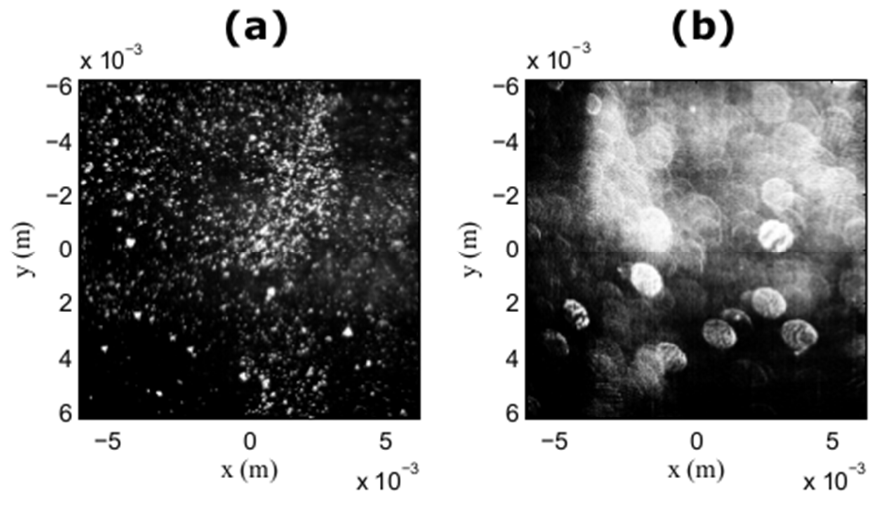
Figure 9. In-focus image of the measurement field when packets of nitrogen particles cross the measurement area ( a ), the out-of-focus image recorded simultaneously ( b ).